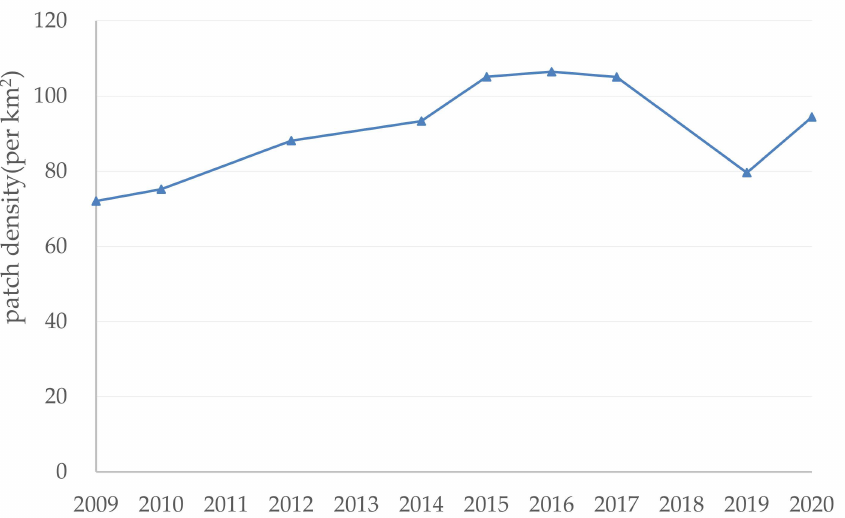
Figure 8. Changes of patch density in the research